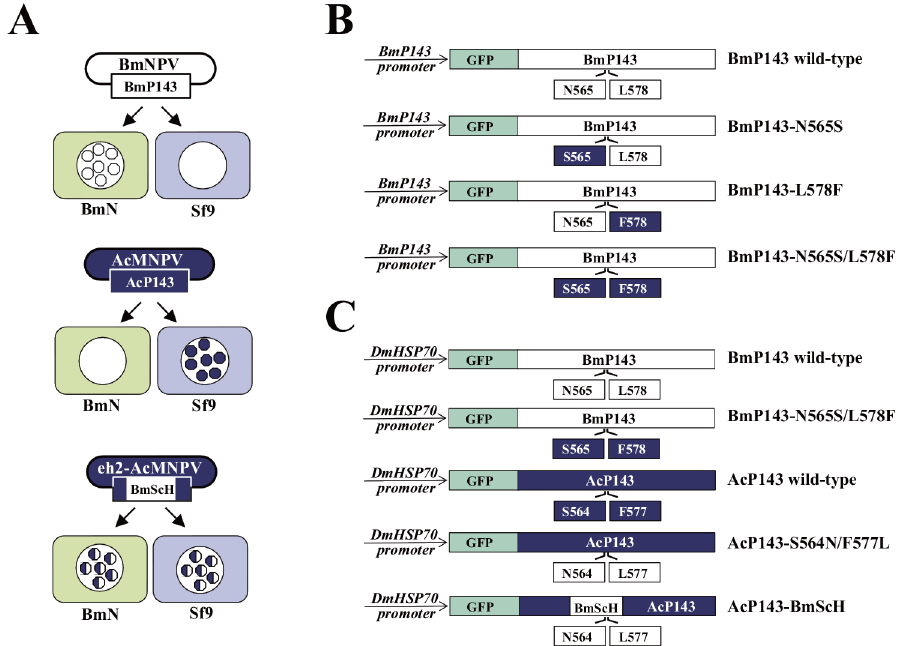
Fig 1. Schematic representation of viruses, cells and recombinant P143 proteins used in this study. (A) BmNPV replicates in B . mori (BmN) cells but does not in S . frugiperda (Sf9) cells, while AcMNPV replicates in S . frugiperda cells but does not in B . mori cells. The AcMNPV recombinant virus (eh2-AcMNPV), in which the host range-specificity region of AcP143 is replaced with the corresponding BmP143 sequence (BmScH), replicates in both B . mori cells and S . frugiperda cells. (B and C) The fusion proteins of GFP and P143 recombinant proteins were expressed in virally infected insect cells under the control of the authentic BmP143 promoter (B) or under the control of the DmHSP70 promoter